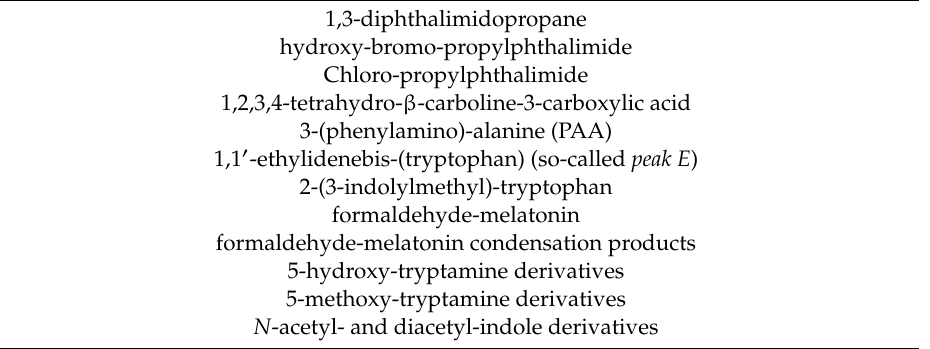
Table 1. Common by-products present in synthetic melatonin